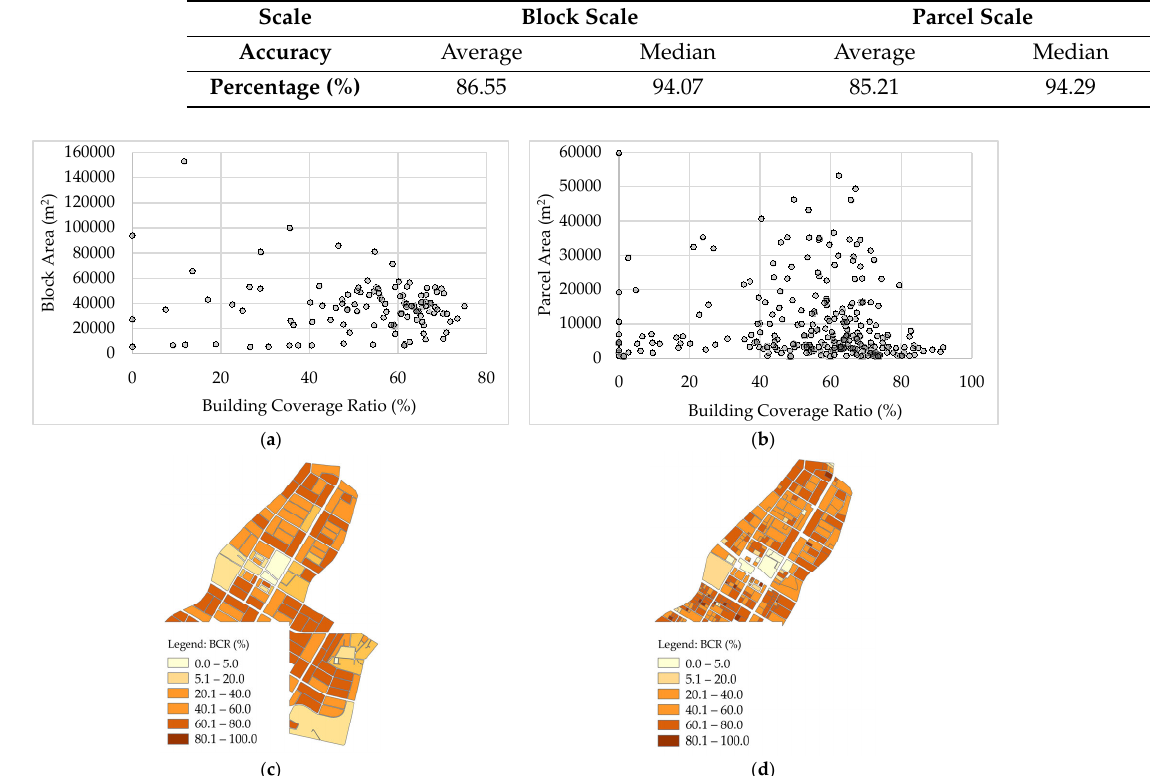
Table 4. The accuracy of BCR by DL.